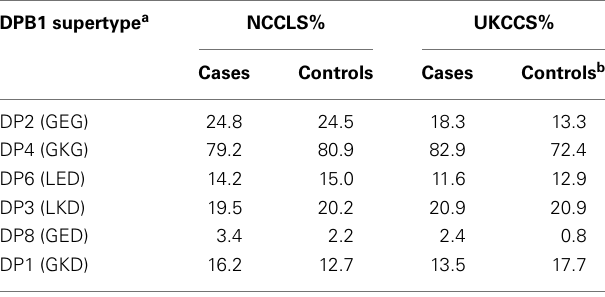
Table 2 | HLA class II DPB1 supertype distributions (percentage of individuals carrying) reported in the UKCCS and NCCLS studies